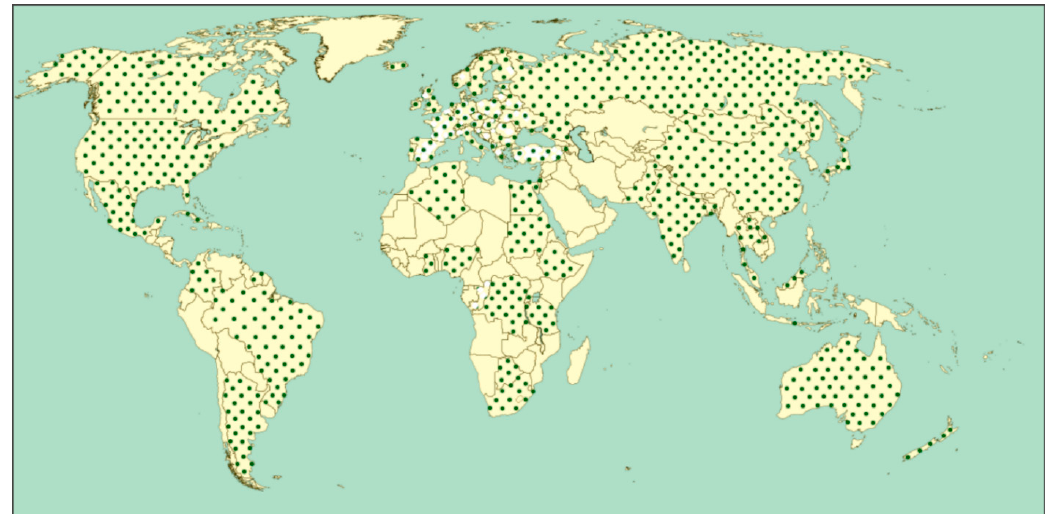
Figure 2. Geographis distribution (green dots) of Demodecidae in the world.